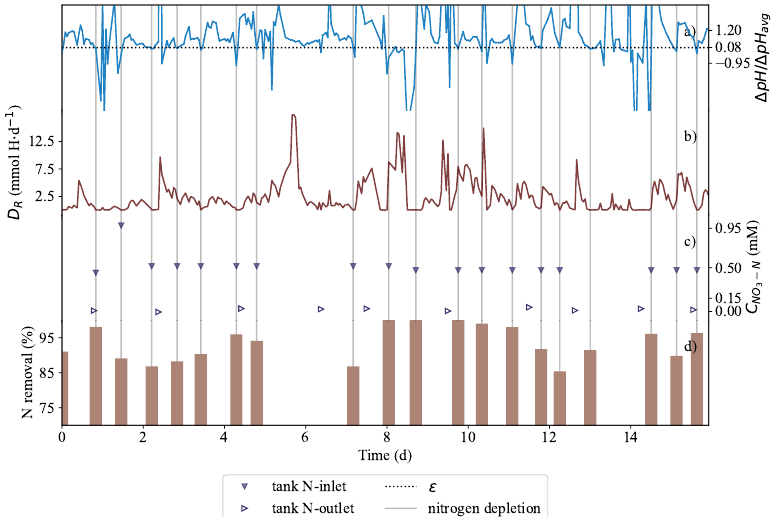
Figure 6. Results showing the nitrate-nitrogen removal in the phytoremediation tank. In subplot ( a ), showing ∆ pH/ ∆ pH avg , at a 92% reduction or at the chosen (cid:101) of 0.08, nitrate was assumed to be depleted (vertical lines are depletion instances and also show when nitrogen was fed). ( b ) The rapid drops in D R correspond to the depletion of nitrate. As soon as nitrate was fed into the tank, D R rapidly increased. ( c ) Nitrate measurements showed that effluent nitrogen was maintained at critically low concentrations. Synthetic wastewater was fed into the tank containing nitrate at depletion/dosing instances. The inlet concentration of the feed is included along with the effluent concentration. ( d ) Shown is the total percentage of nitrogen removal by L. minor measured before nitrogen was dosed. The phytoremediation system achieved a high fraction of removal almost regularly every 10–14 h.